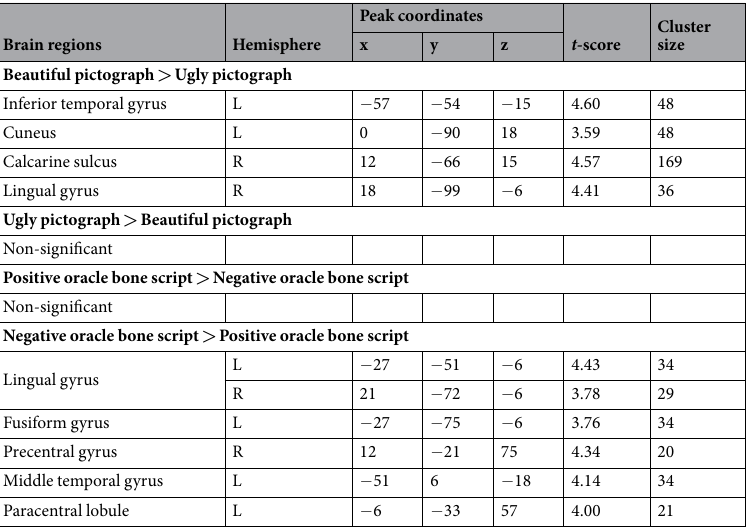
Table 5. Cortical networks of the analysis of variance between beautiful and ugly stimuli. Note: Coordinates refer to the stereotactic space of the Montreal Neurological Institute. The statistical significance refers